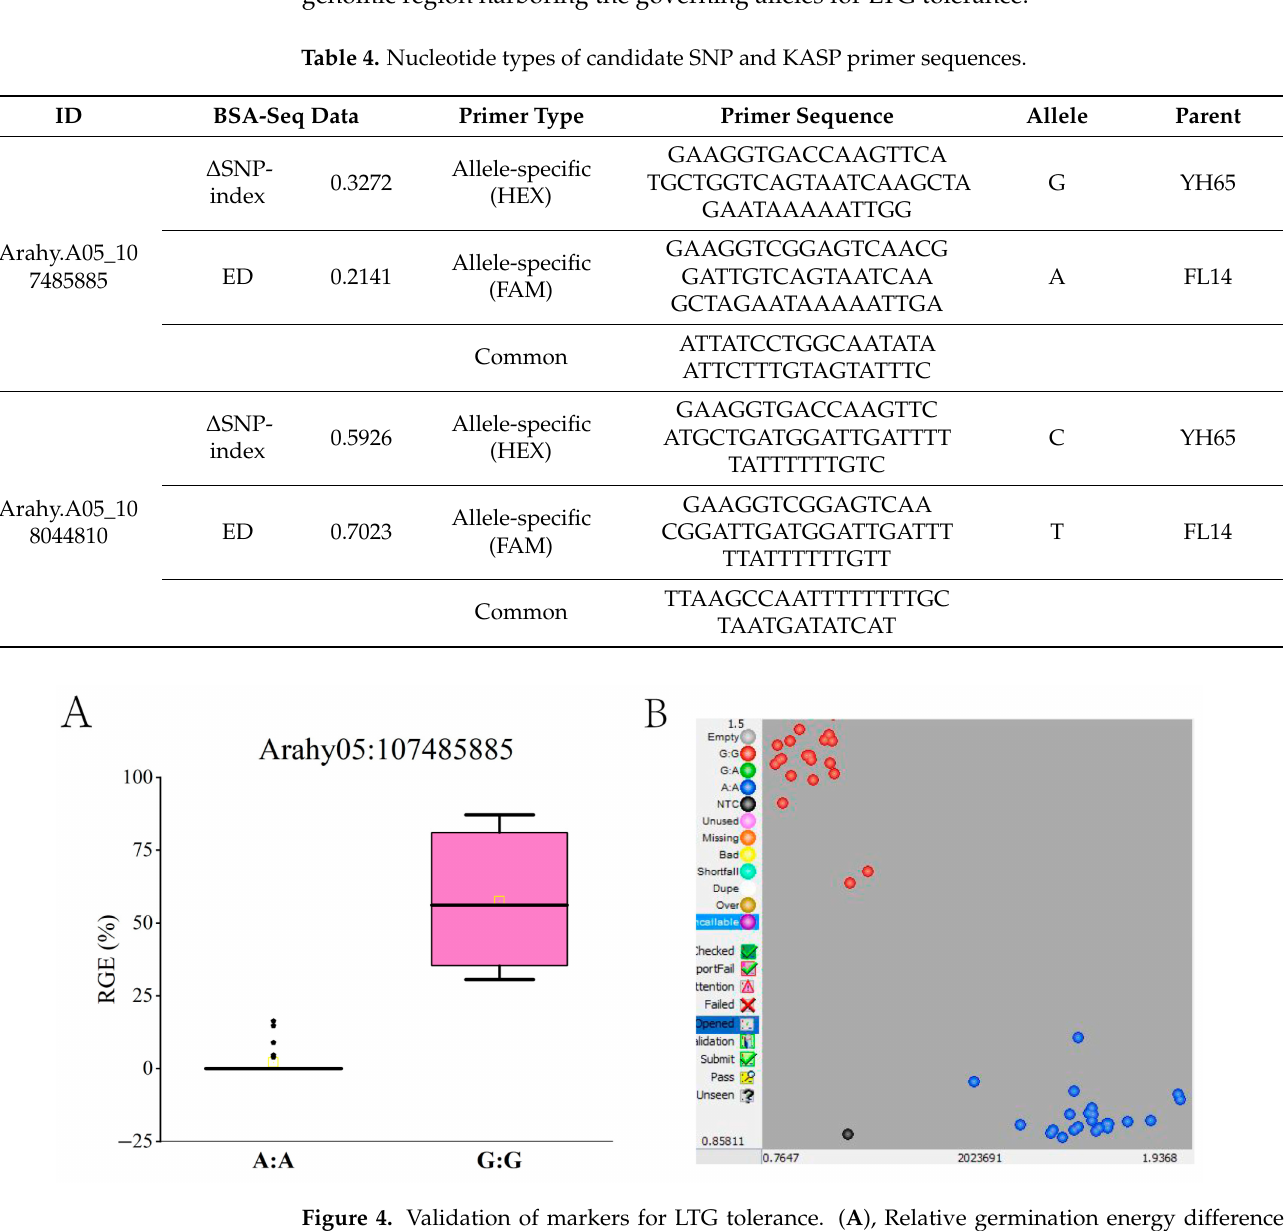
Figure 4. Validation of markers for LTG tolerance. ( A ), Relative germination energy difference between two genotypes in verification group at the Arahy05:107485885. The boxplots were drawn using software of Origin 2021. ( B ), KASP marker genotyping for the candidate SNP